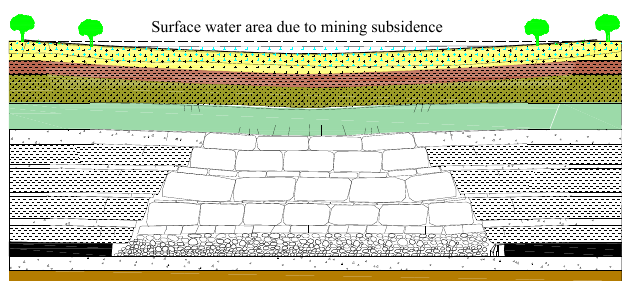
Figure 1. Mining damage transfer process .